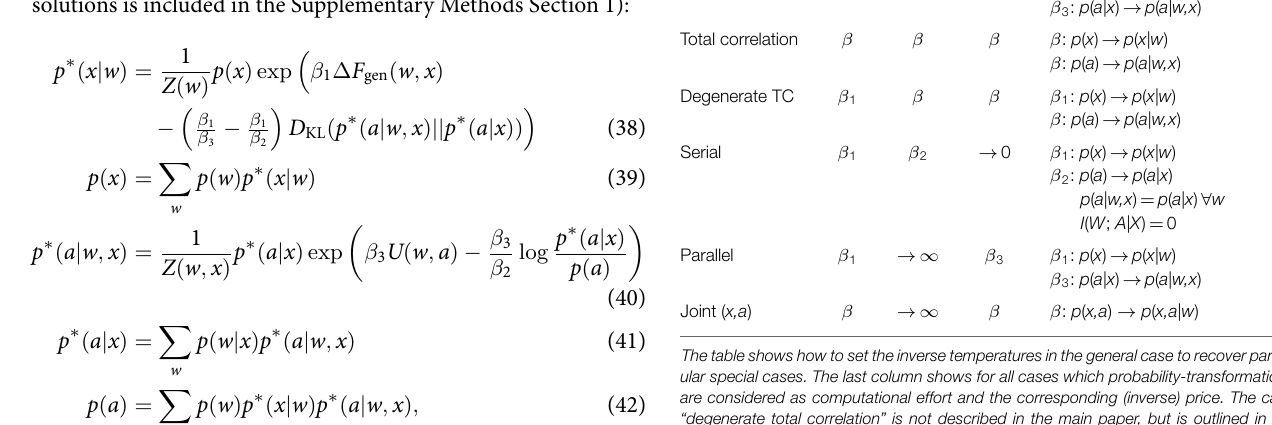
TABLE 2 | Recovery of special cases from the general, unifying case by specific settings of the inverse temperatures . Case (inverse) price per transformation